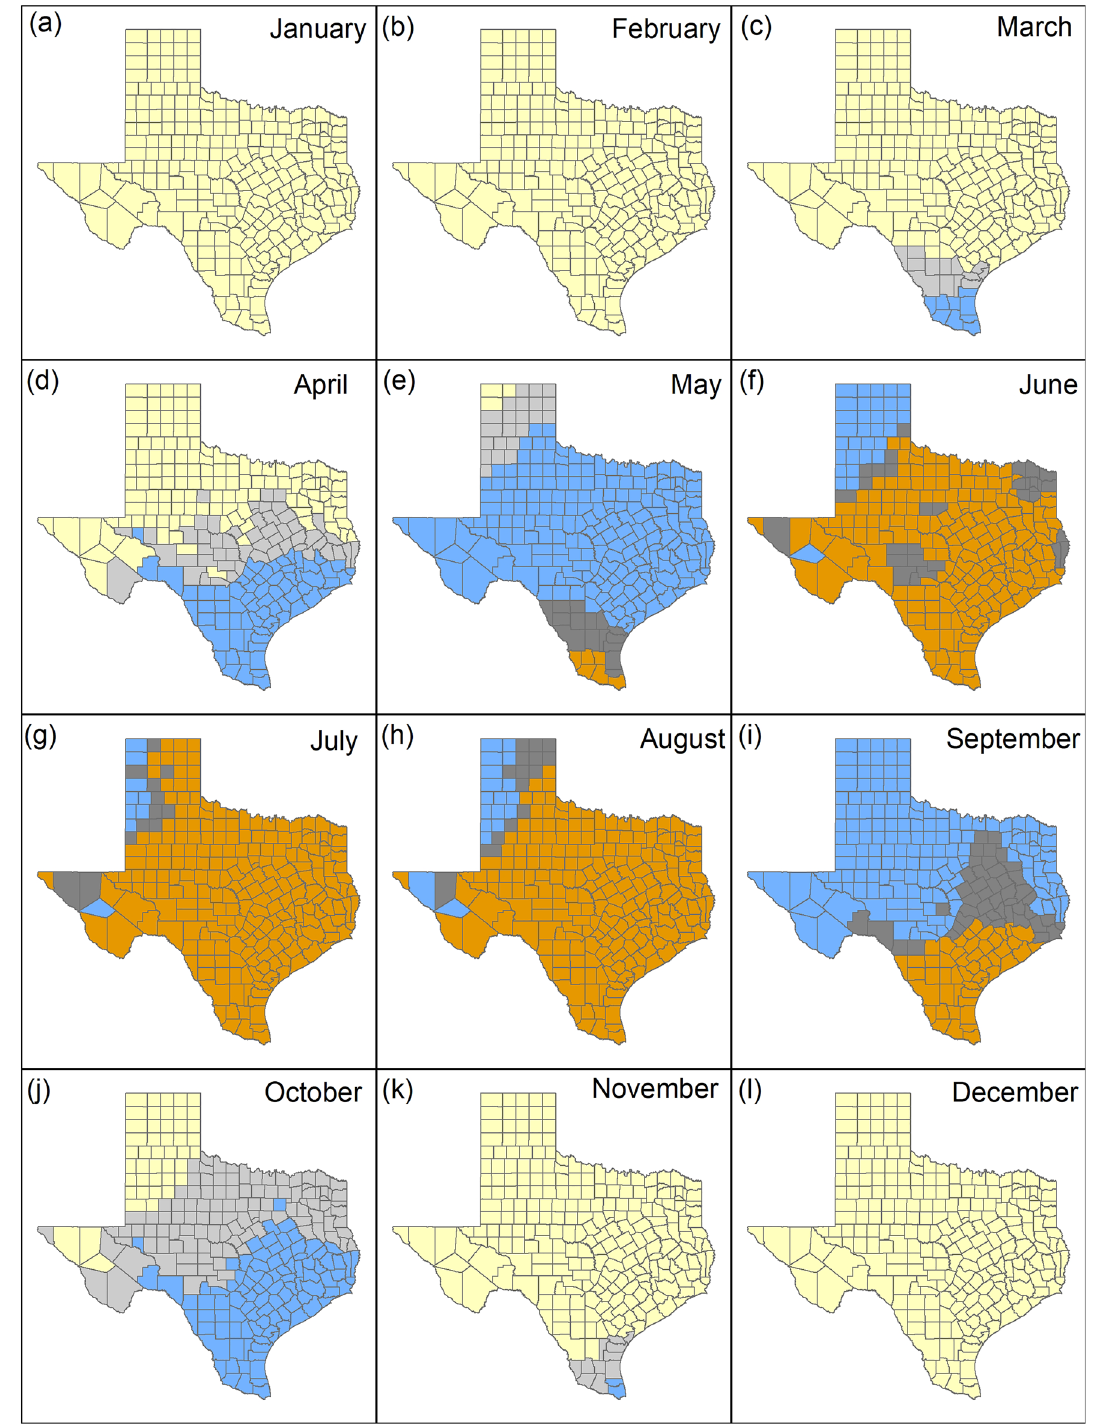
Figure 7. Monthly mean temperature (°C) from 2010 to 2019 compared to ensemble model 2021–2040 projections aggregated by county. Yellow counties represent areas where temperatures are below the maximum clear ambient temperature in which deer can be detected (≤ 20 °C), blue counties represent areas where temperatures are below the maximum cloudy ambient temperature in which deer can be detected (≤ 27 °C), and orange counties represent areas where temperatures are above the maximum ambient temperatures for deer detection (> 27 °C). Light gray counties represent areas where temperatures increased from clear to cloudy maximum ambient temperatures and dark gray counties represent areas where temperatures increased above 27